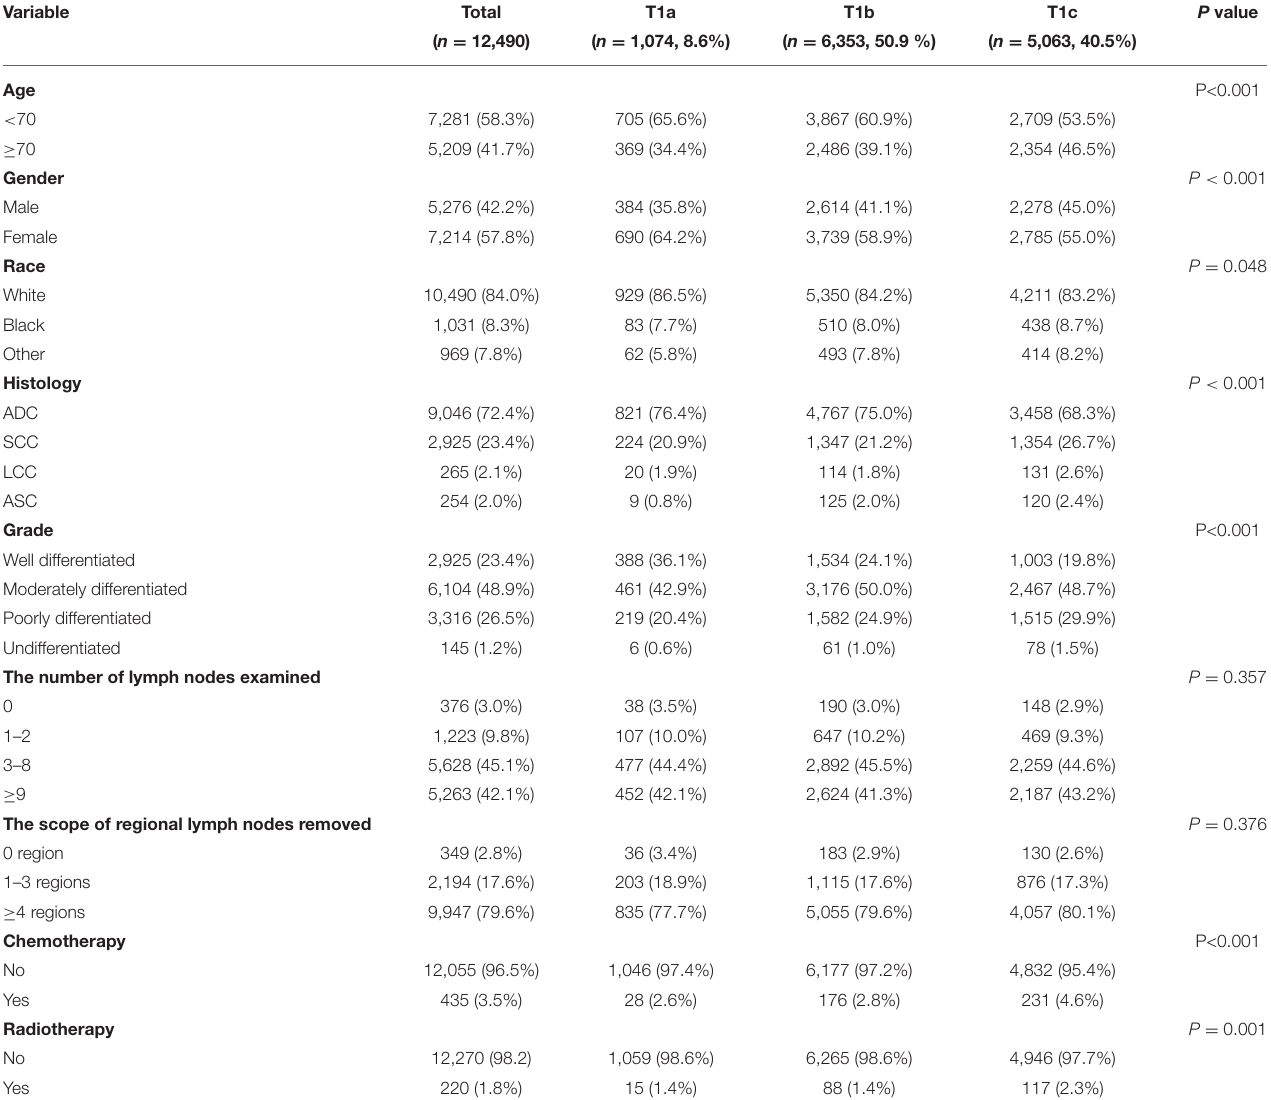
TABLE 1 | Clinicopathological characteristics of NSCLC patients in the SEER database.